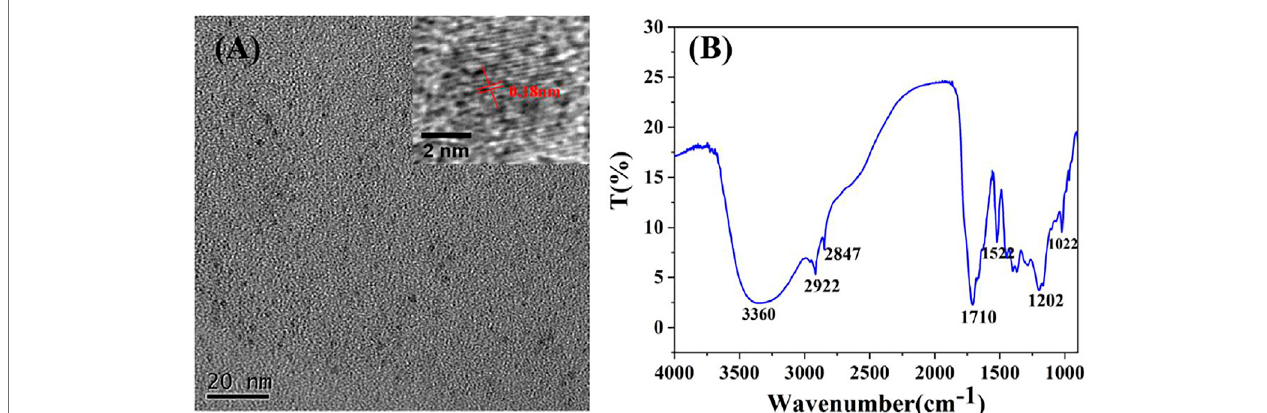
FIGURE 2 | (A) TEM image and HRTEM of CDs (B) FT-IR spectrum of CDs sample.